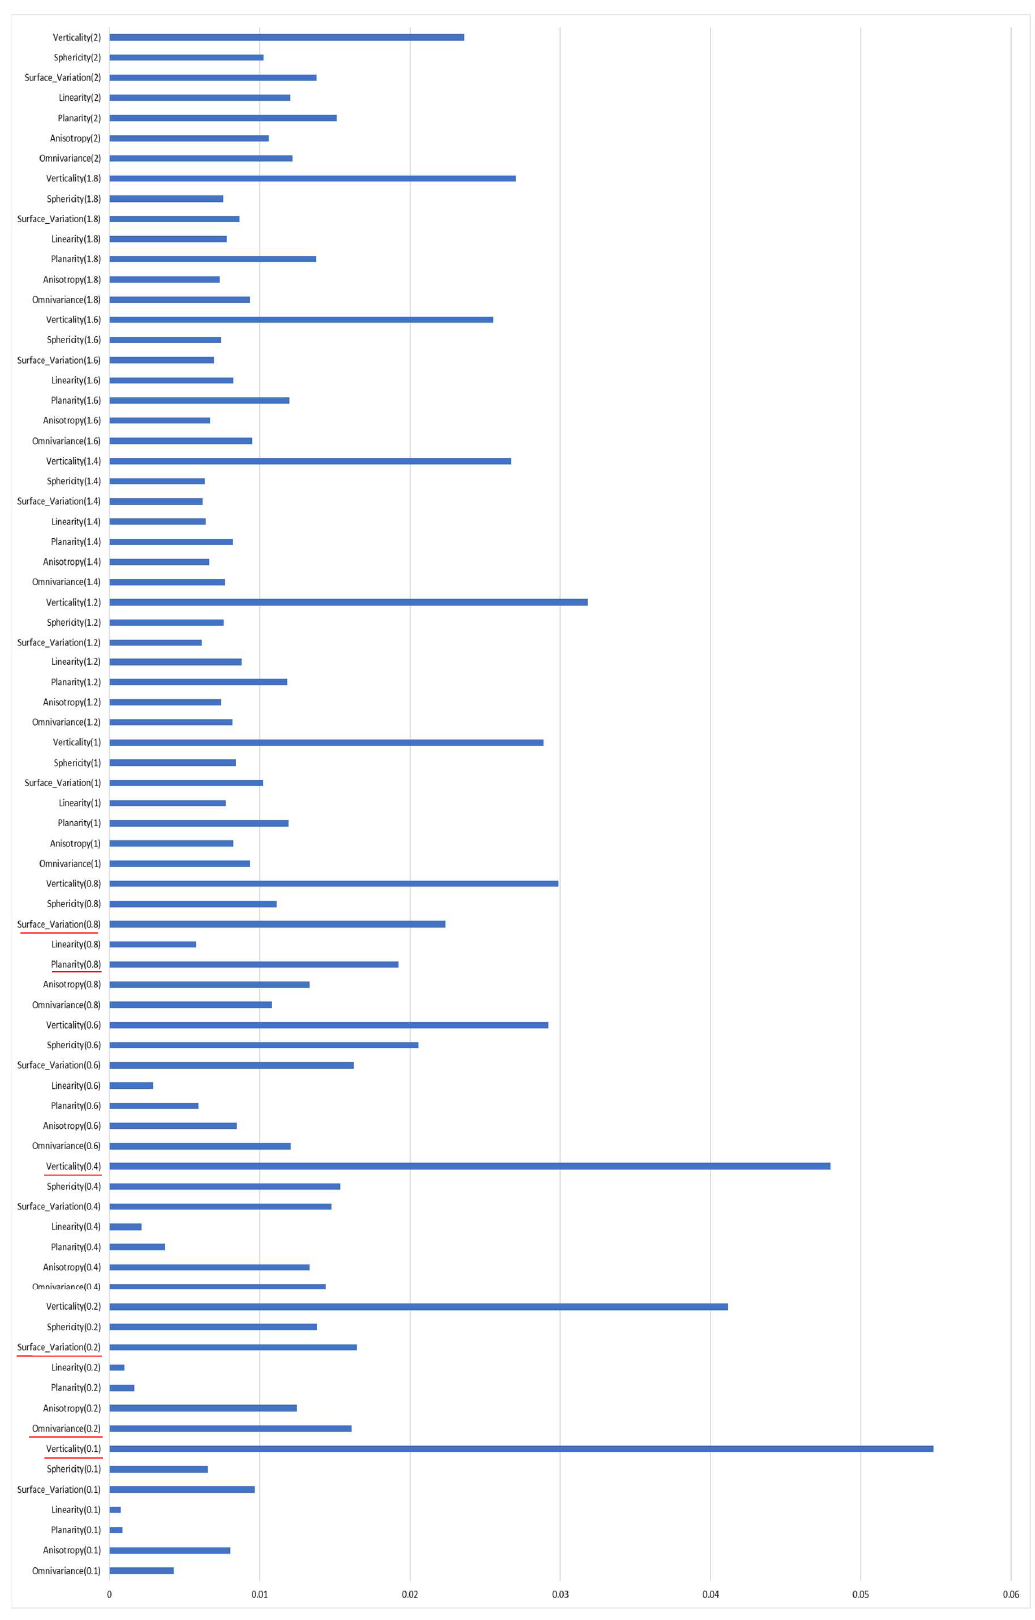
Figure 6. Feature importance ranking for a multi-scale classification. The features used in this study have been underlined in red.